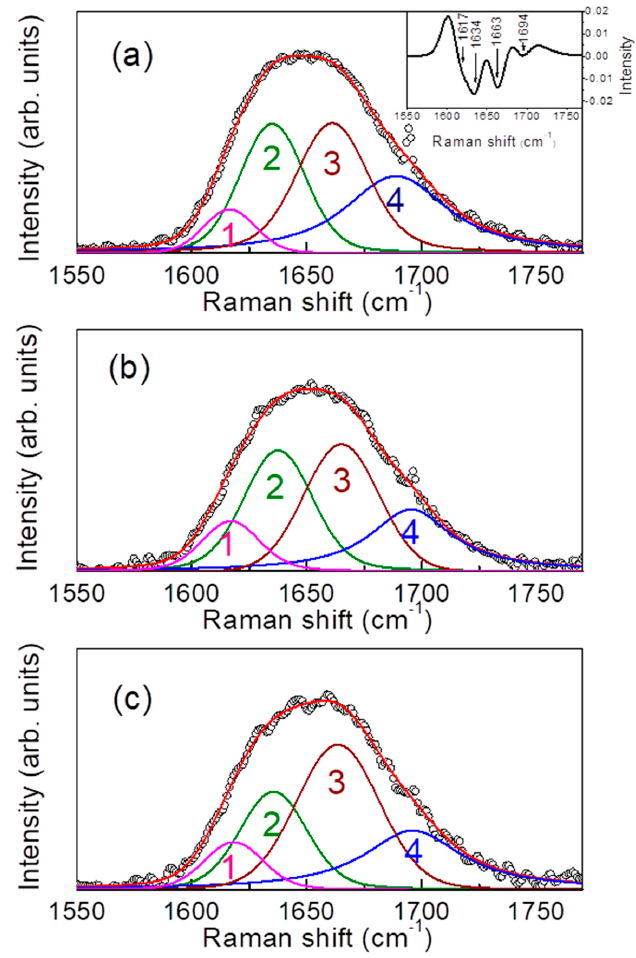
Figure 3. Curve-fitting results in the amide I region for a non-IBD subject ( a ), for a subject with CD ( b ) and for a subject with UC ( c ). Experimental points: black circles; best-fit: red line; individual components: magenta, green, brown, and blue lines. In the inset, example of second derivative profile calculated for the experimental Raman spectrum of the non-IBD subject.